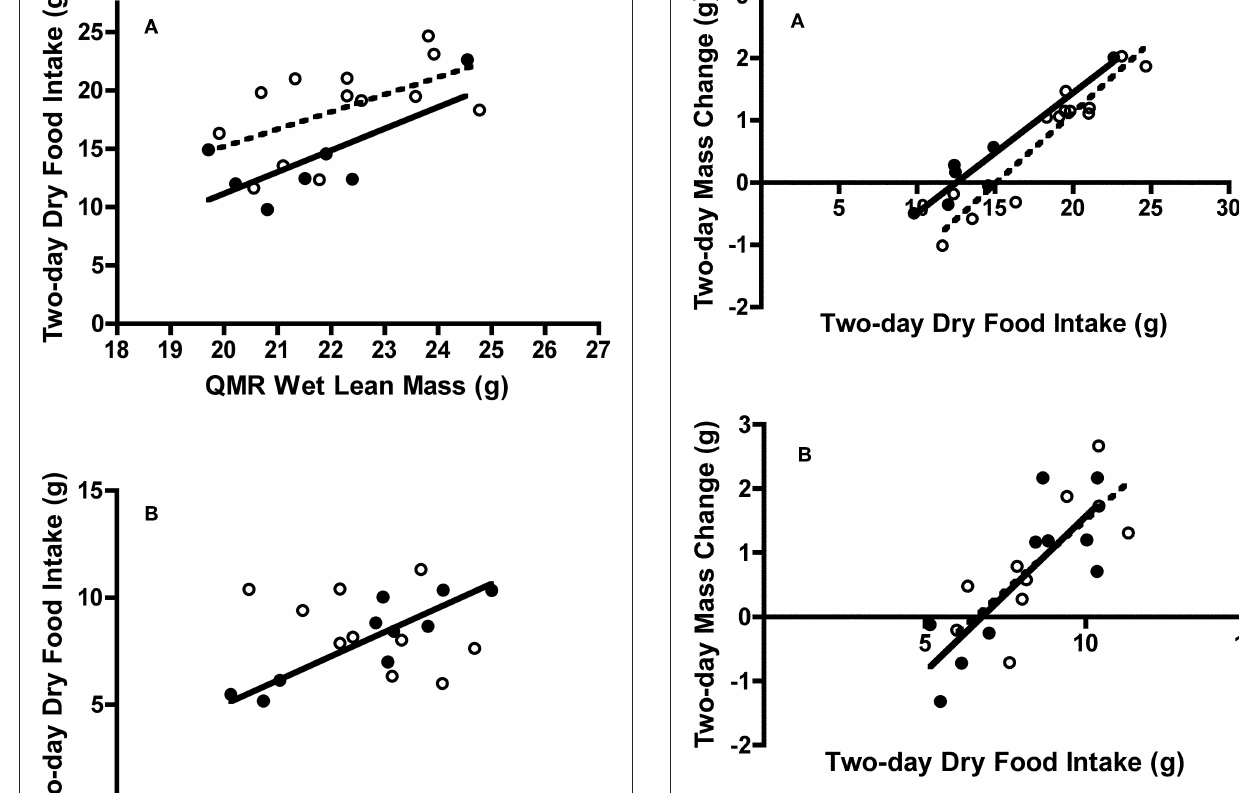
FIGURE 7 | Effect of dry food intake on mass change of adult and juvenile (A) Swainson’s thrushes and (B) white-throated sparrows during a 2-day total collection mass balance feeding trial. All birds captured at Long Point, ON, Canada during fall 2011 migration stopover. Filled circles and solid lines represent adults: thrushes mass change = − 2.41 ( ± 0.41) + 0.193 ( ± 0.028) * dry food intake, r 2 = 0.90; sparrows mass change = − 3.28 ( ± 1.02) + 0.485 ( ± 0.124) * dry food intake, r 2 = 0.66. Unfilled circles and dashed lines represent juveniles: thrushes mass change = − 3.43 ( ± 0.46) + 0.227 ( ±